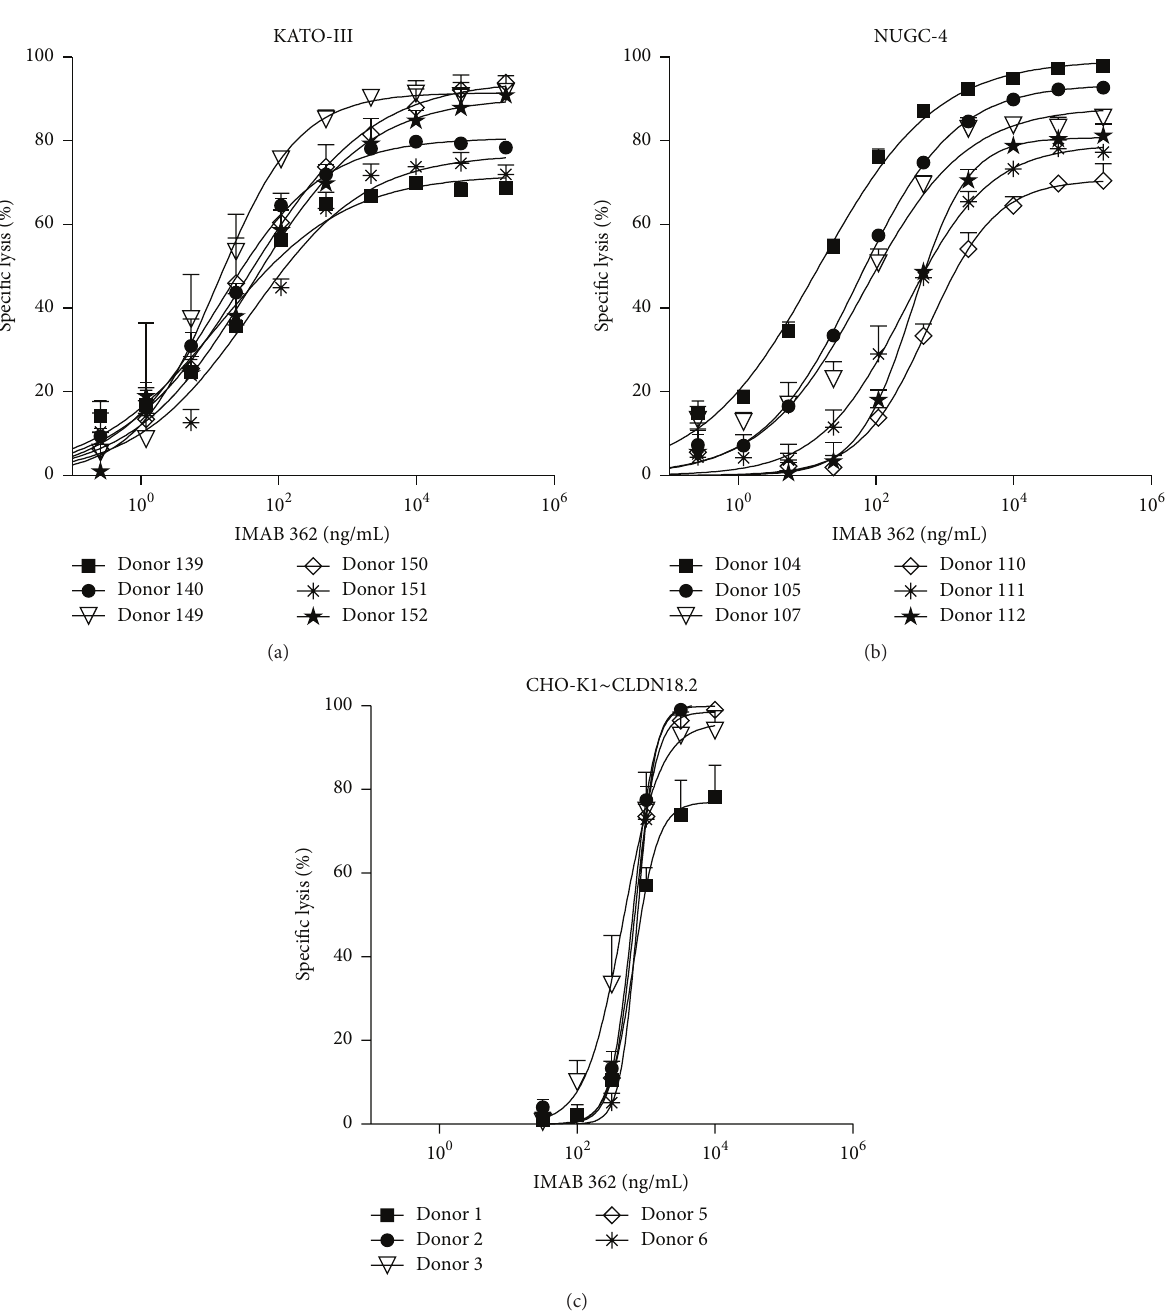
Figure 5: The luciferase IVT RNA-based assay efficiently assesses mAb-induced ADCC and CDC of tumour cell lines. ADCC assay using (a) KATO-III and (b) NUGC-4 cells. KATO-III and NUGC-4 cells endogenously expressing hCLDN18.2 were transfected with 7 𝜇 g luc2 IVT RNAandseededinto96-wellplatesindependently.4 hlater,IMAB362atdifferentconcentrationsandhumanPBMCs(E :